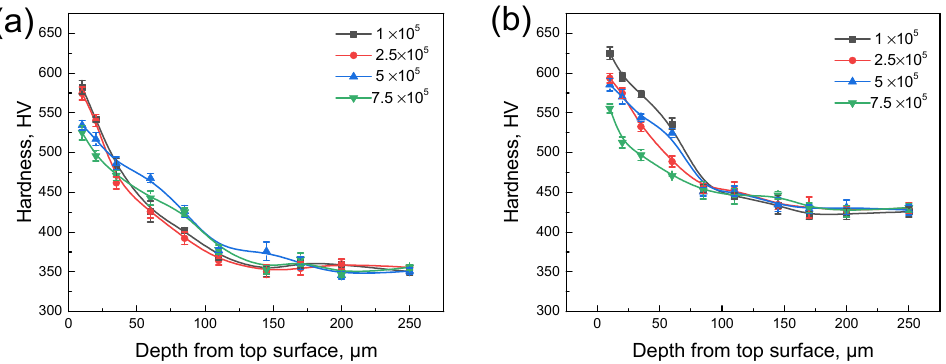
Figure 10. Hardness distribution of worn samples with the depth from top surface. ( a ) 1280G rail steel; ( b ) 1380G rail steel.